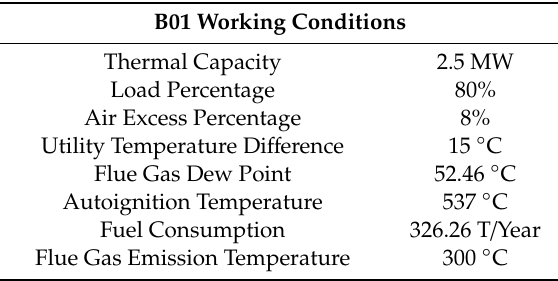
Table 2. Summary of B01 working conditions.